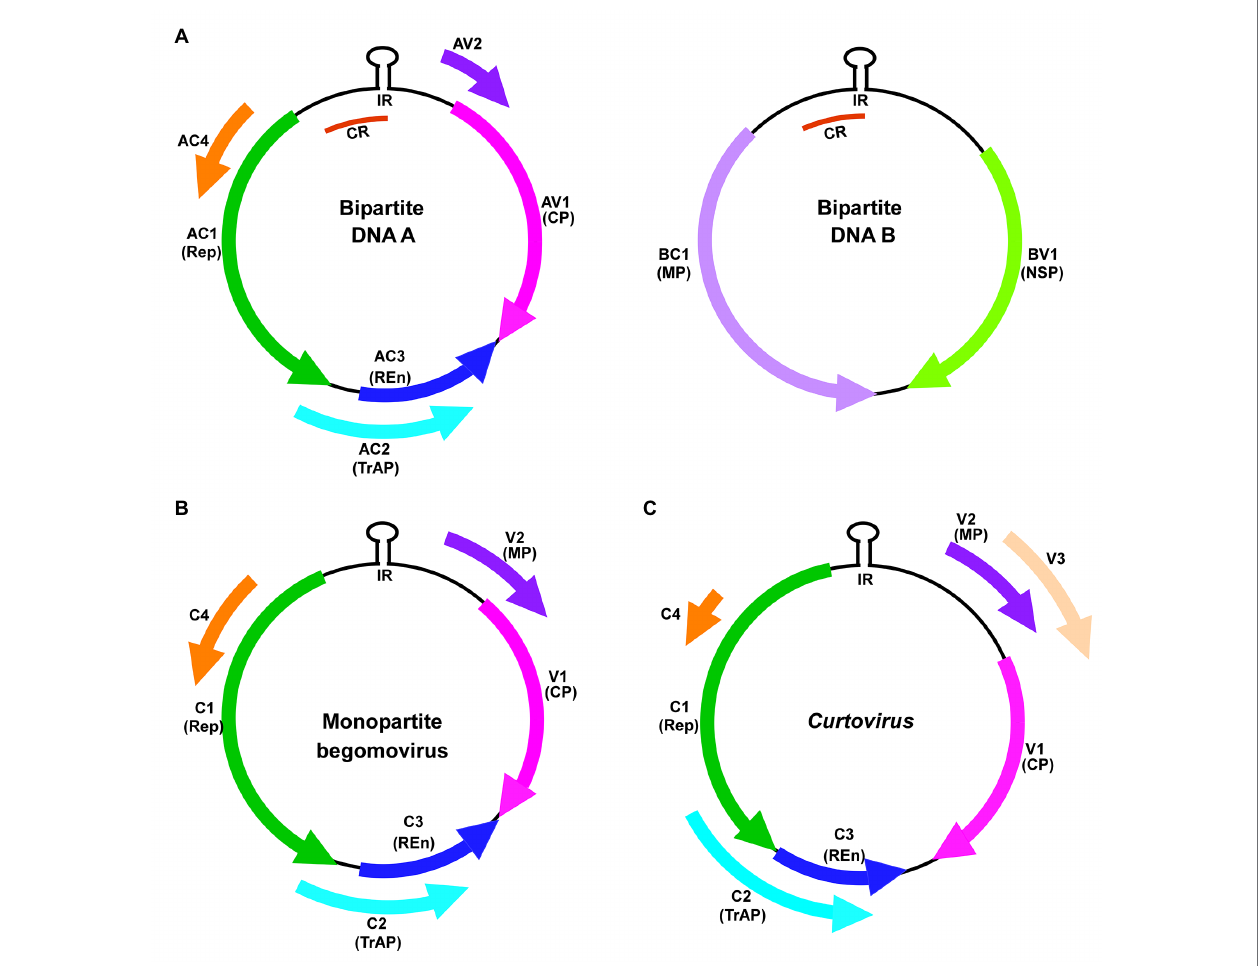
FIGURE 1 | Genomic organization of (A) bipartite begomovirus, (B) monopartite begomovirus, and (C) curtovirus. Virion-sense (V) or complementary-sense (C) strand open reading frames (ORFs) and corresponding protein products are coded by color. CR, common region; CP, coat protein; IR, intergenic region; MP, movement protein; NSP, nuclear shuttle protein; REn, replication enhancer protein; Rep, replication-associated protein; and TrAP, transcriptional activator